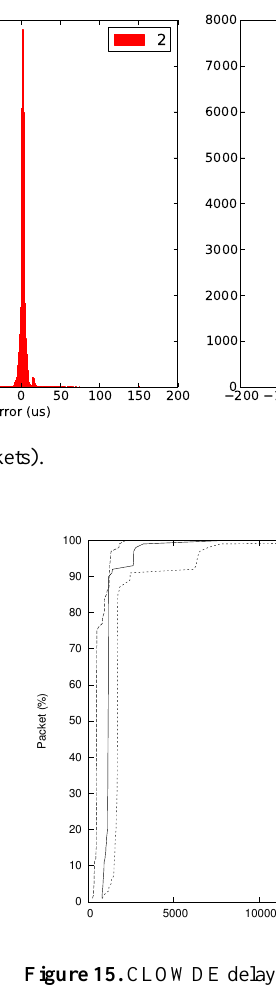
Figure 14. Sample timing delay. Fig. 14: Sample timing delay